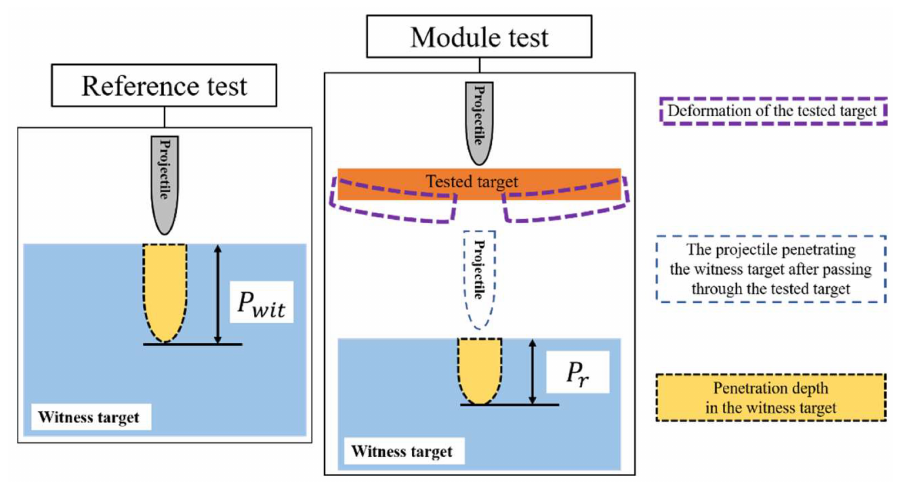
Figure 3. Schematic of the test